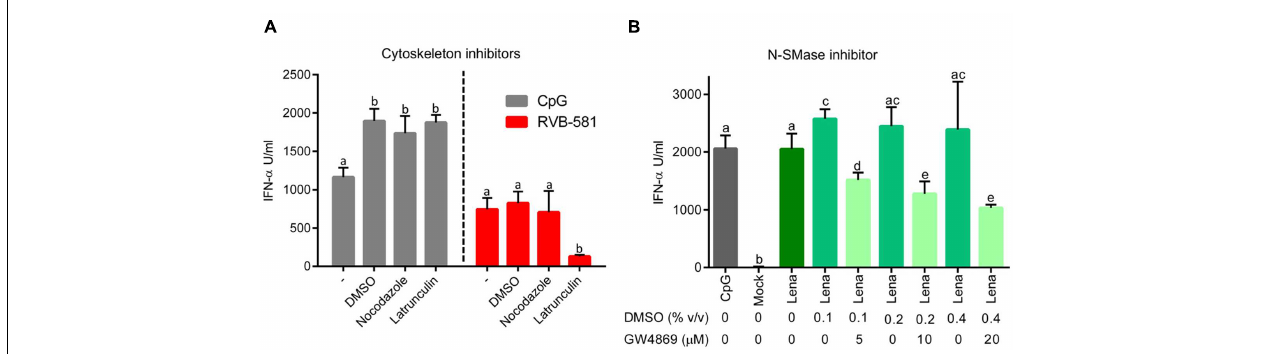
FIGURE 4 | Role of cytoskeleton and membrane ceramide in pDC activation by PRRSV-infected MØ. (A) MØ were infected with PRRSV RVB-581 for 90 min, washed and then treated with the cytoskeleton inhibitors nocodazole (10 µ M; interferes with microtubule polymerization) or latrunculin (3 µ M; inhibitor of actin polymerization) or DMSO as control for 2 h at 39 ◦ C. After three washes, MØ were co-cultured with pDC. Control wells were stimulated with CpG D32. DMSO controls showed an increase in IFN- α secretion by pDC stimulated with CpG D32. (B) MØ were infected with PRRSV Lena for 90 min, washed and then co-cultured with pDC. Then DMSO controls or different concentrations of GW4869 (inhibitor N-SMase) at 5, 10, and 20 µ M were added to the co-cultures. Mock-treated MØ and CpG D32 stimulation were included as controls. N-SMases are important in the metabolism of sphingomyelin and required to produce cell membrane ceramide and phosphocholine, which are important during intercellular interactions. For (A,B) , the IFN- α production was measured after 20 h of incubation in co-culture. The data represent mean values of three replicates with standard deviation, and represent three (A) and two (B) independent experiments. Different letters on top of the bars indicate significant difference based on the Mann–Whitney test ( P < 0.05), whereas bars sharing same letters indicate no significant